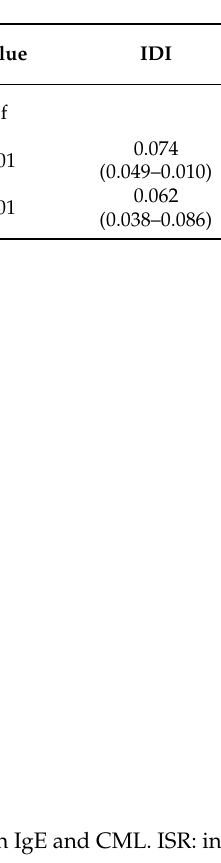
Table 4. The predictive power of models for ISR.